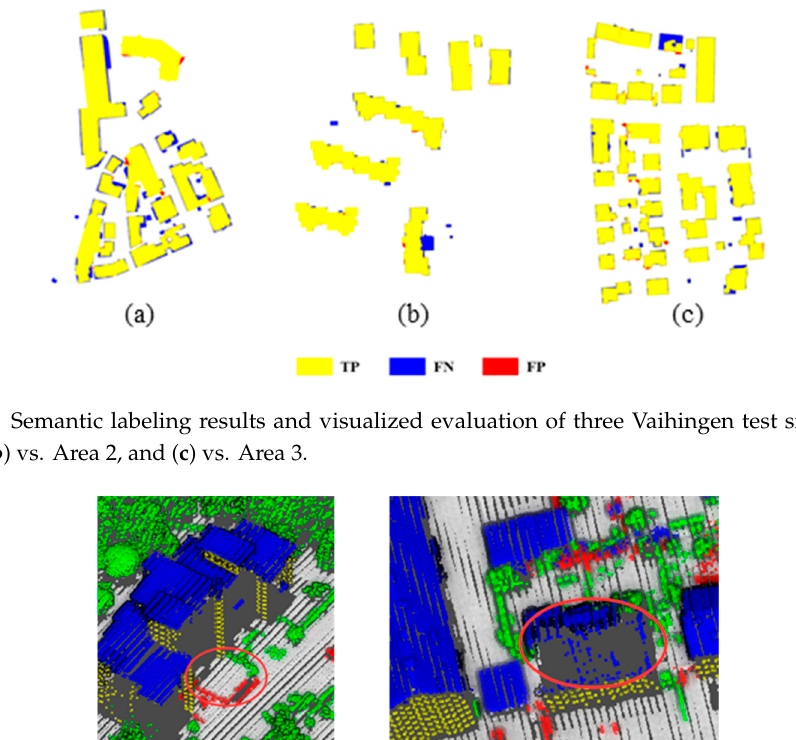
89.7 Note:Those methods’ abbreviations are consistent with the benchmark tests in WG II/4 of ISPRS commissions II. http://www2.isprs.org/commissions/comm3/wg4/tests.html 4.2. Hong Kong Dataset The Hong Kong dataset covers an area larger than 3 km 2 , with a length and width larger than 3 km and 1 km, respectively. Figure 10 shows the tiled image of this area. It is clear that the complexity of this scanning scene is far greater than that of the Vaihingen data in terms of the density of buildings and the architectural morphology of structures. Whole point clouds were already manually labeled with five relevant categories (i.e., ground , building , low vegetation , high vegetation , and other ) by the Hong Kong government. Since the structures were so complex and irregular, a building was no longer separated into roof and façade parts. Moreover, the viaducts and footbridges in this dataset were also labeled as building . Here we should mention that although classifying the viaducts and footbridges as building will bias the classification in terms of the real environment, it does not bias the results of the experiments since we used the same categories in the training data. Furthermore, many old houses surrounded by vegetation cannot be well separated in the ALS point clouds cases even by a human operator. Thus, to find and separate vegetation is a big challenge in the semantic labeling of cases in such a dataset. The vegetation has been divided into two categories: low vegetation and high vegetation . In our experiments, we selected a specific part of the area to train the model. Figure 11 shows the whole area in the point clouds with the semantic labels: ground (orange), building (blue), low vegetation (light green), high vegetation (dark green), and other (red). The area in the red square is